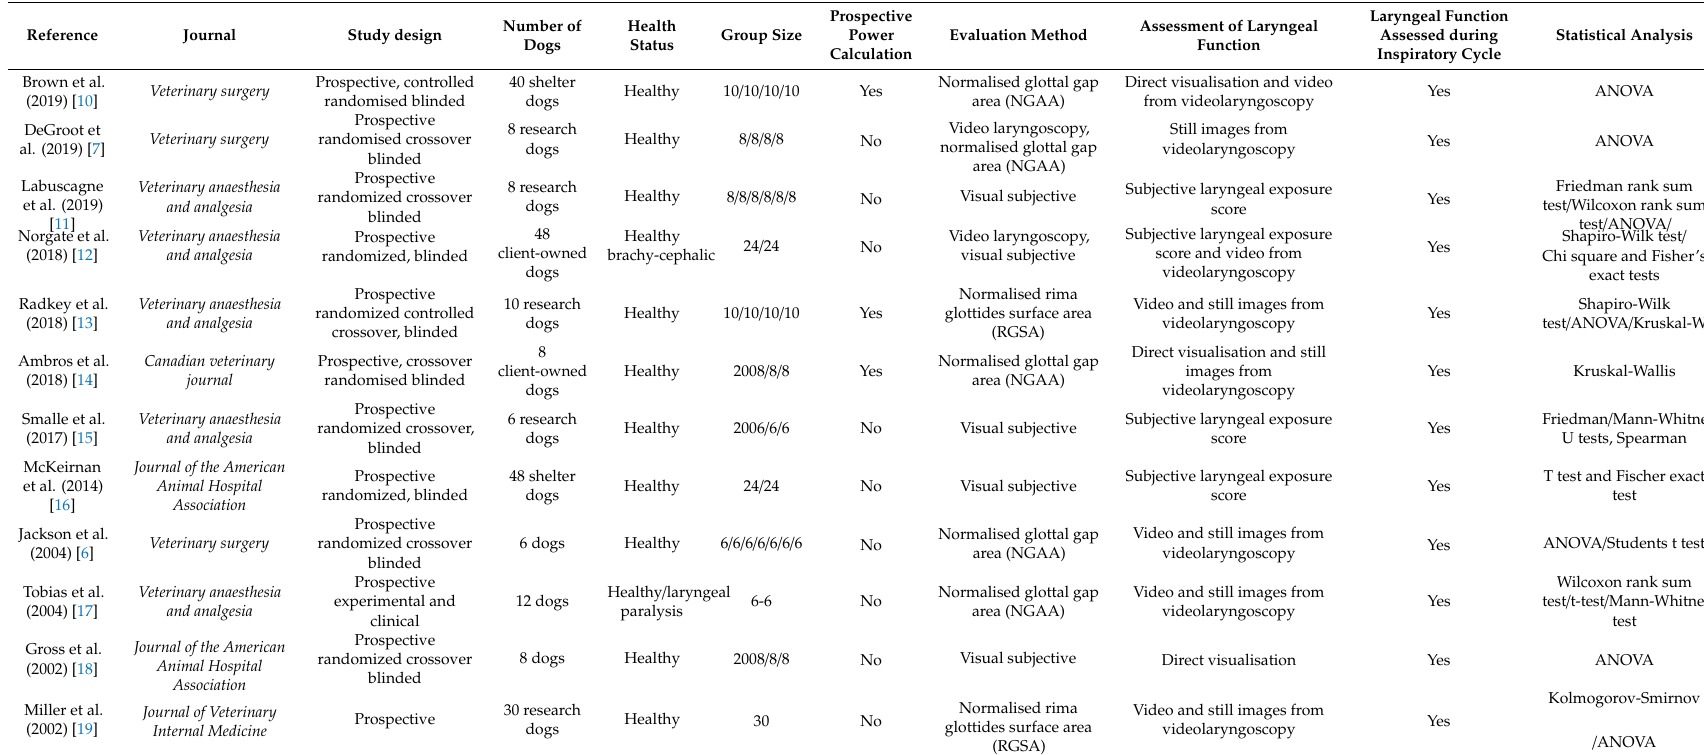
Table 1. Results and study features of standardised methodological assessment of the 12 included studies evaluating the e ff ects of anaesthetic drugs on the laryngeal motion in